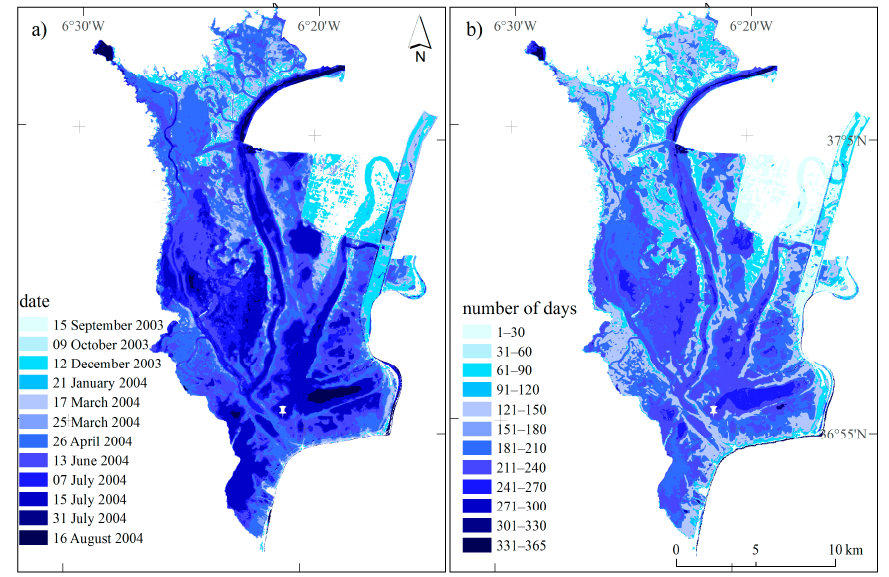
Figure 4. ( a ) Overlay of flooding masks for the wet cycle in 2003–2004 (total rainfall = 775 mm); ( b ) calculated hydroperiod in number of days for the same cycle. Color palettes and number of classes are the same for comparison purposes. The white tack indicates the location of the N28 limnimetric scale.